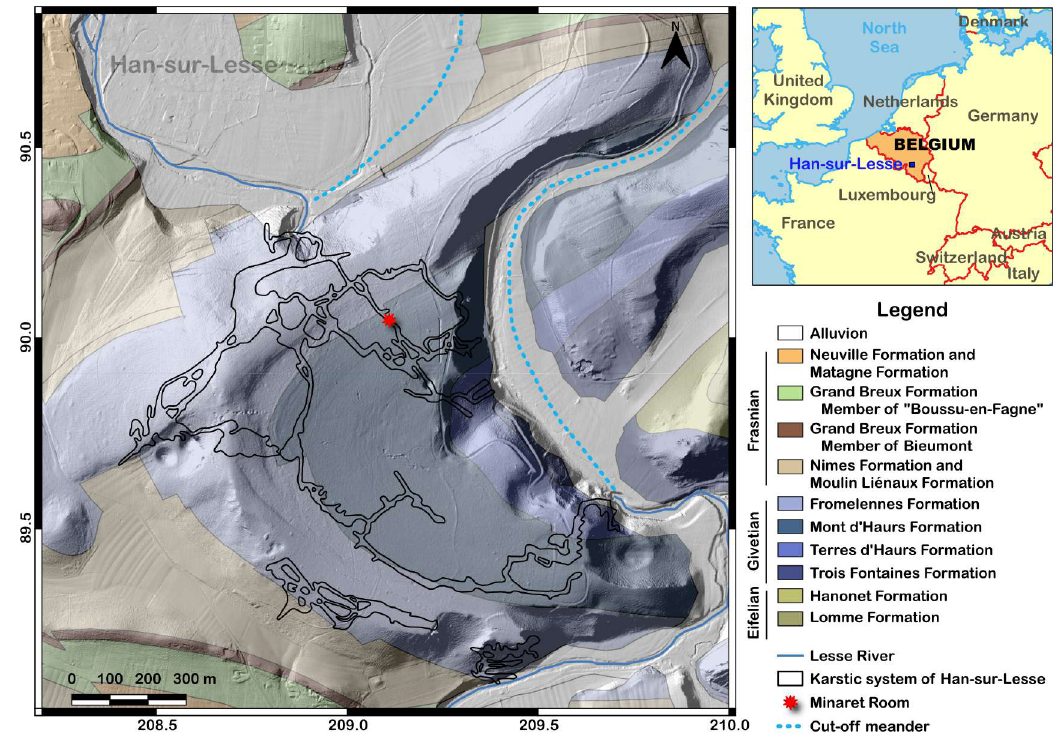
Figure 1. Geological map of the Karstic system of Han-sur-Lesse (Belgian Lambert 1972, in km). The Han-sur-Lesse cave is formed within the Givetian limestone formations (in blue). The cut-o ff meander (light blue dotted line) can be observed in the alluvial formation (white). The surrounding Eifelian and Frasnian formations are made by shales. The location of the Minaret room (experimental area) is shown by a red star. This map is inspired by [37] and [38] (based on the new geological map of Wallonia, [39]). The topographical background is the Digital Elevation Model (LIDAR) of Wallonia from the Service Public de Wallonie